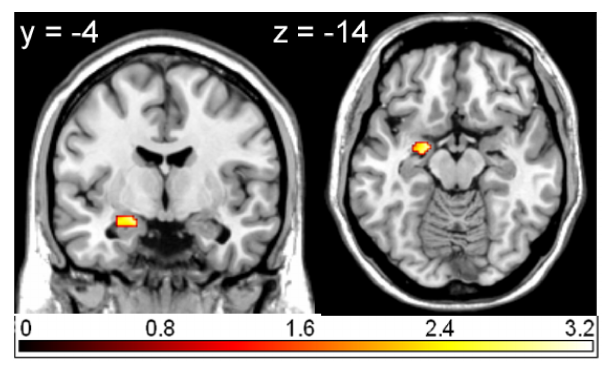
Figure 1 | region of interest (rOi) activation. Left amygdala activation (peak voxel at − 18, − 4, − 14) for the contrast unpleasant relative to pleasant pictures overlaid on a single subject T1 scan (overlay threshold: p < 0.05; minimum cluster size of k = 5). Color-coded t-values are shown.